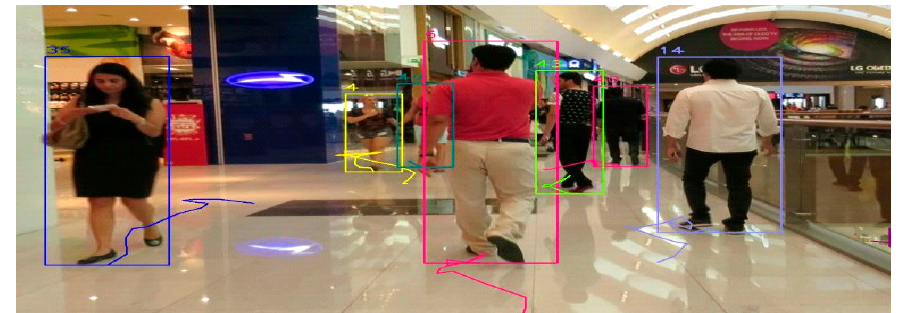
Figure 9. The proposed model (SCT) results using MOT 16-11.